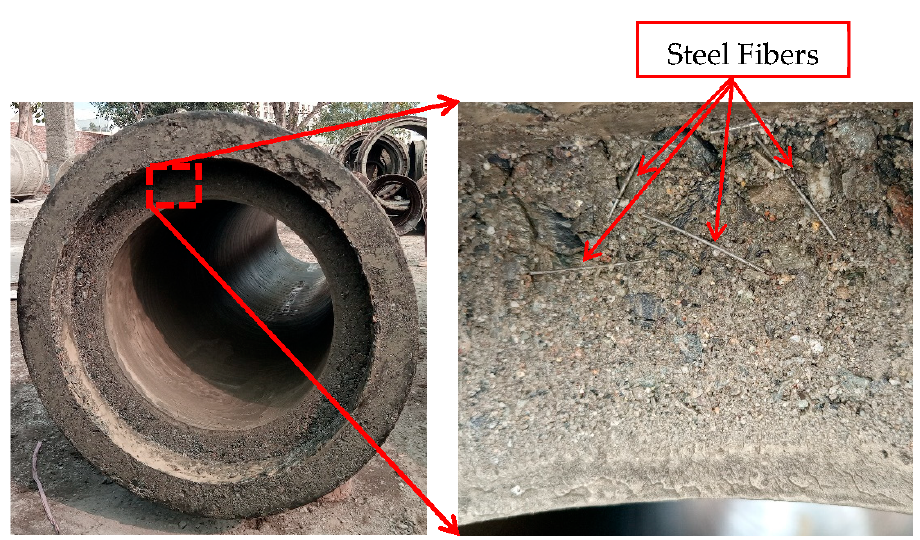
Figure 14. Distribution of steel fibers seen in the freshly cast concrete pipe.